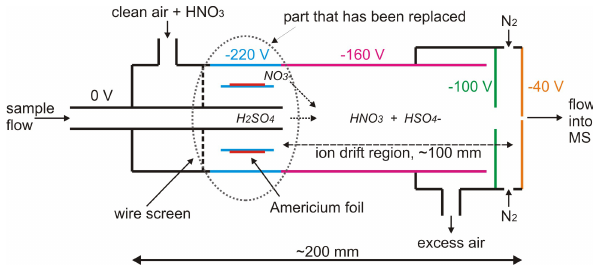
Fig. 1. Schematical drawing of the ion source and the inlet system of the instrument used for the H 2 SO 4 measurements. The colors represent different voltages applied to the different sections of the inlet and ion source region. Note that the voltage applied to the americium foil is − 220V as well but has been assigned a different color for